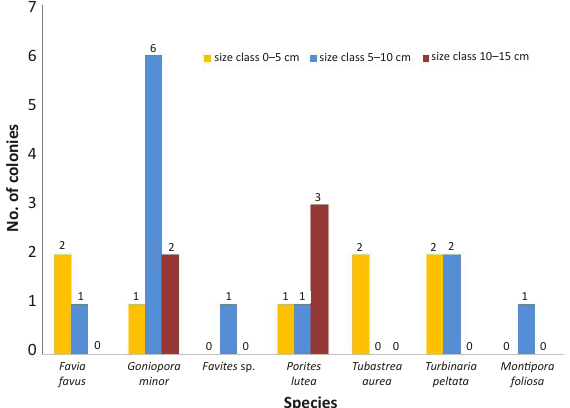
Figure 3. Size class of coral colonies occurring in the sampled